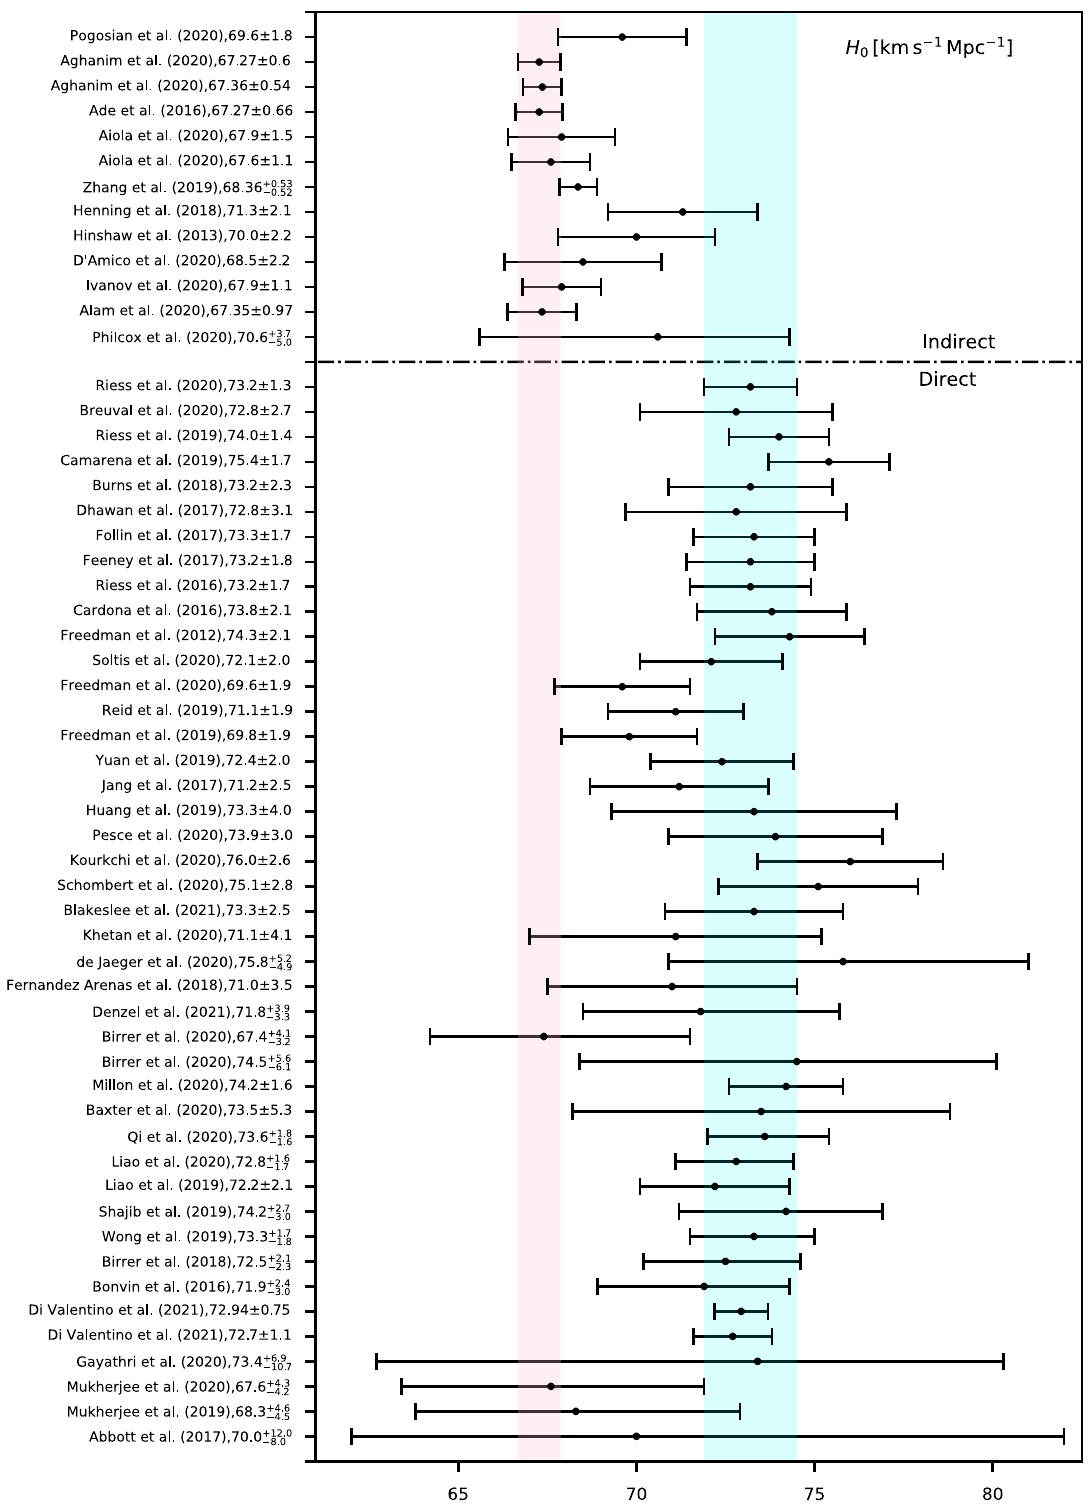
Fig. 8 Hubble tension whisker plot with references from Ref. [612]. The pink band represents Planck results [613] and the cyan band is for cepheids from Ref.